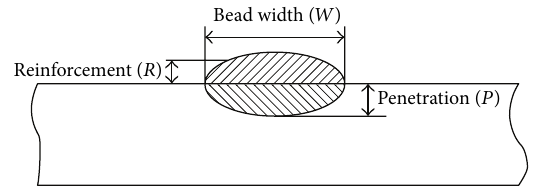
Figure 1: Clad bead geometry.